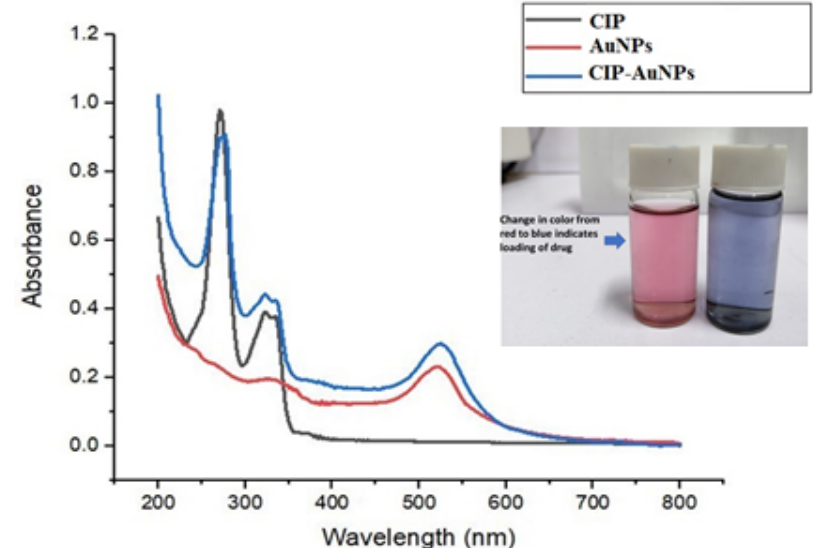
Figure 1. UV–Vis spectra of CIP, AuNPs, and CIP-AuNPs.